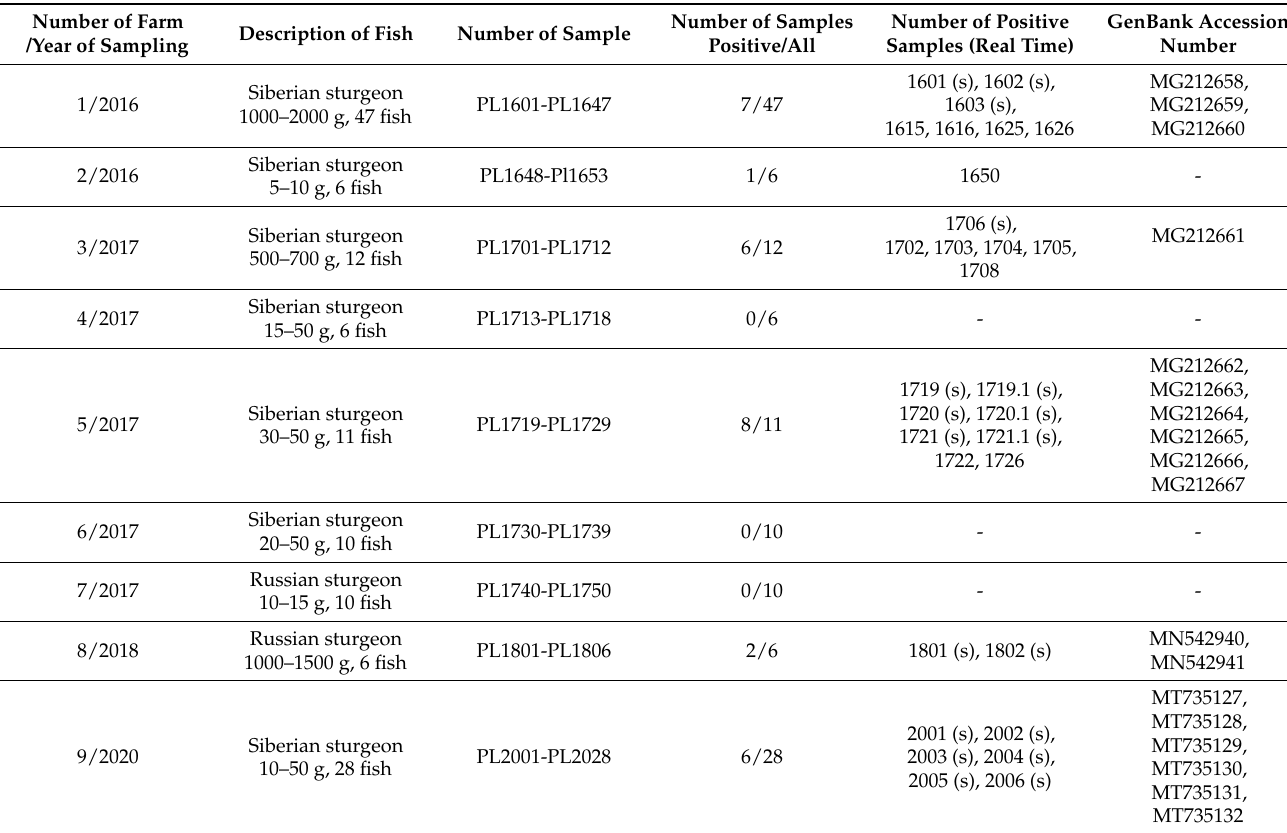
Table 2. Fish samples description. (S) Samples sequenced for the genetic analysis of mimivirus. Number of Farm /Year of